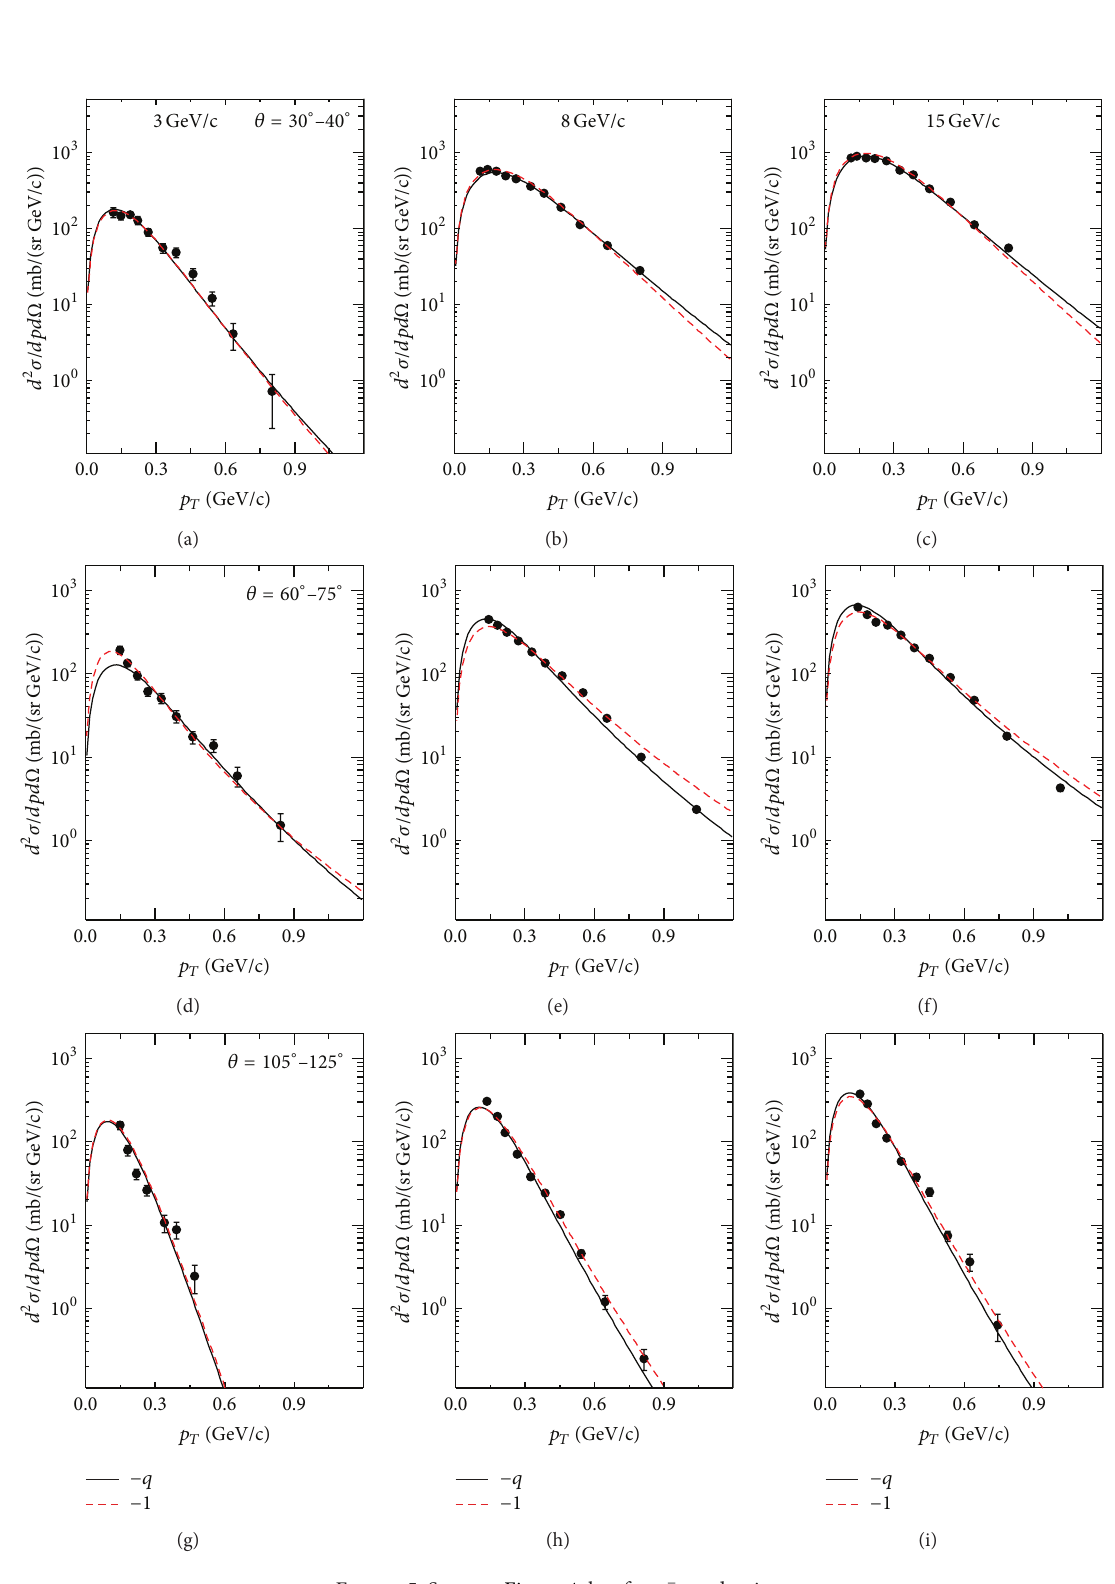
Figure 5: Same as Figure 4, but for 𝜋 −